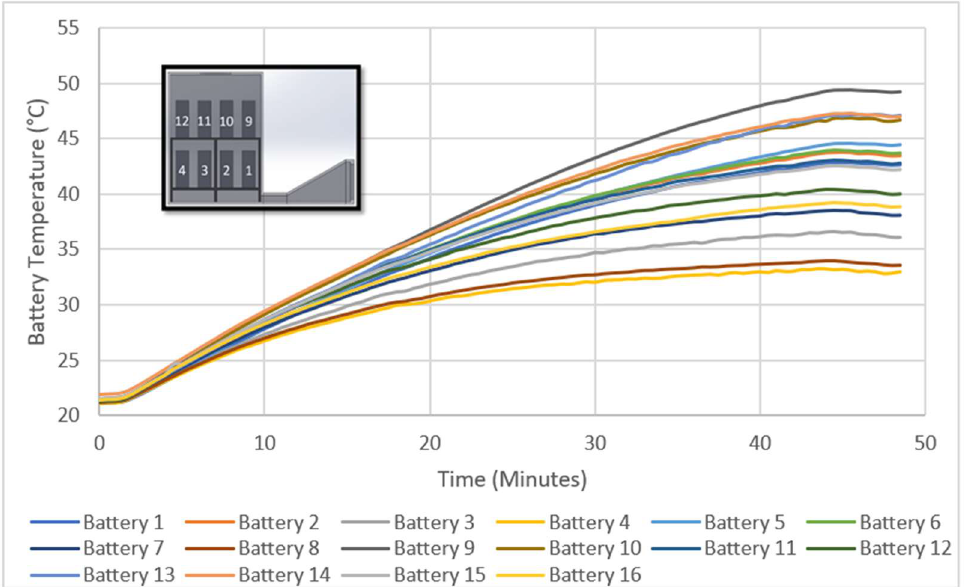
Figure 10. Default model battery temperatures. Batteries near the front of the enclosure have higher temperatures while batteries opposite the inlet experience lower temperatures.